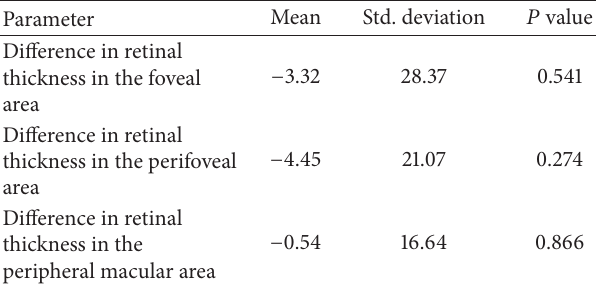
Table 1: Difference between retinal thicknesses before versus after hemodialysisindiabeticretinopathypatientsindifferentpartsofthe eye.